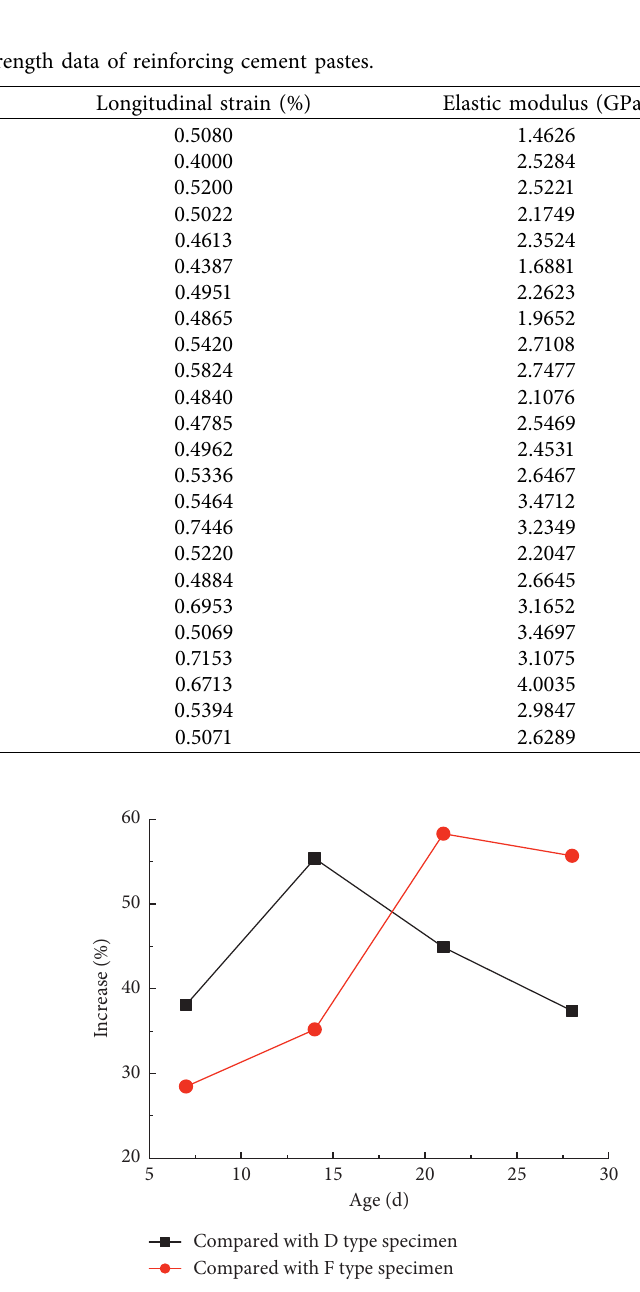
Figure 12: Trend of compressive strength increasing